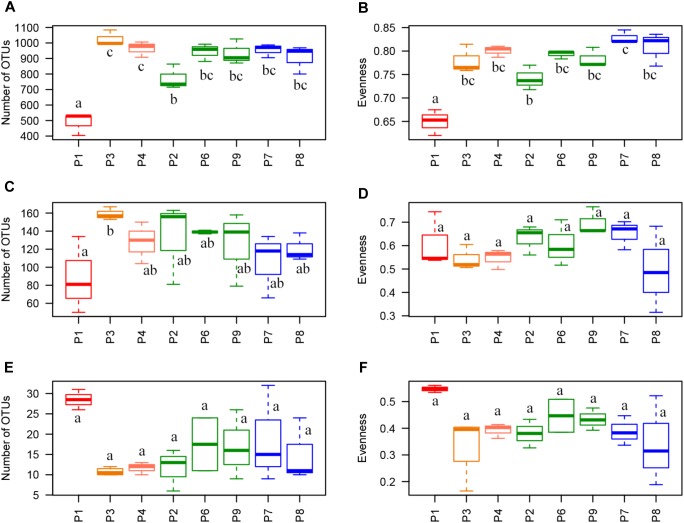
Alpha-diversity indices. Richness index (Observed OTUs) and evenness index (equitability or Pielou’s index) per sample for (A,B) 16S rRNA data, (C,D) ITS data, and (E,F) TEF1 data. Letters indicate statistical differences between samples (p < 0.05). Telexx variety samples are plotted in green and P8600 variety samples are plotted in blue.